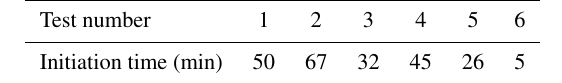
Table 3. Initiation time of landslide for six